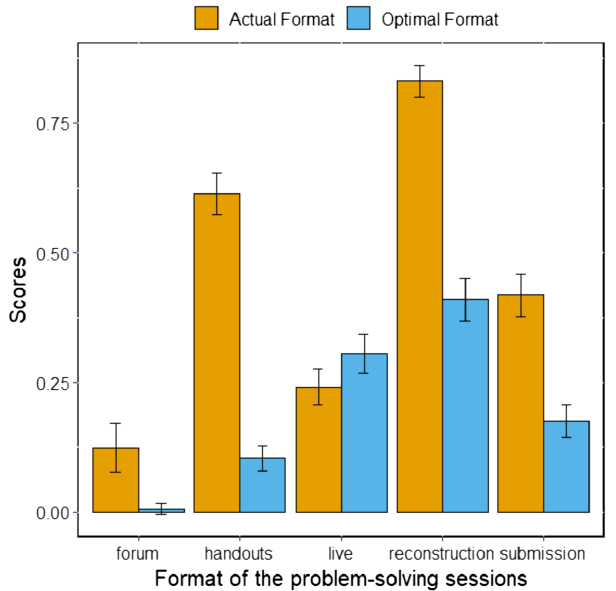
FIG. 3. Formats of the online recitations that students actually experienced during the COVID-19 summer term and judgments about optimal